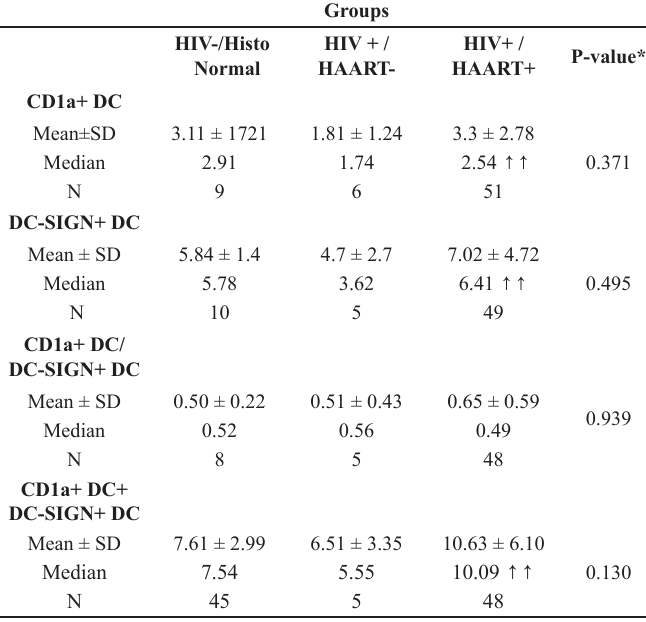
TABLE 2 - Median of dendritic cells in the study of